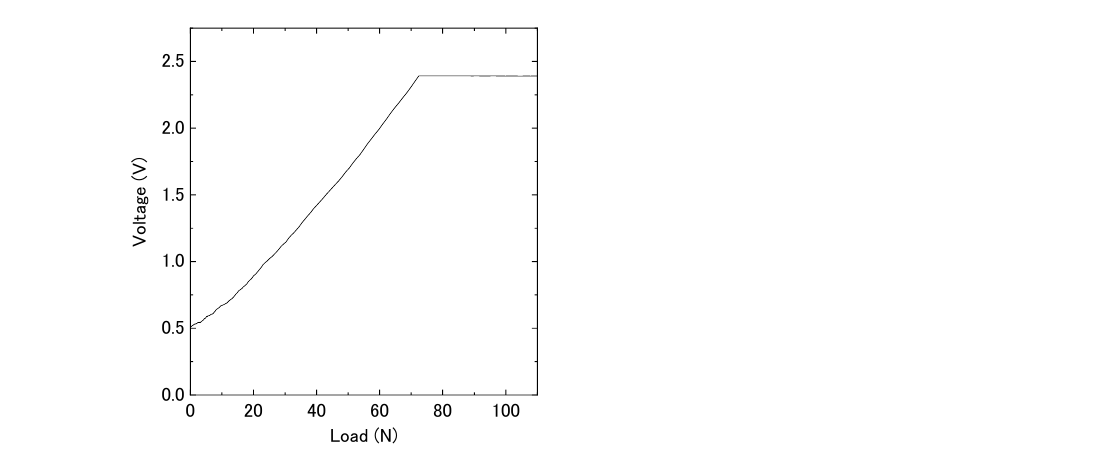
Figure 2. Correlation between the output voltage of the force sensor in MG materials and the load.